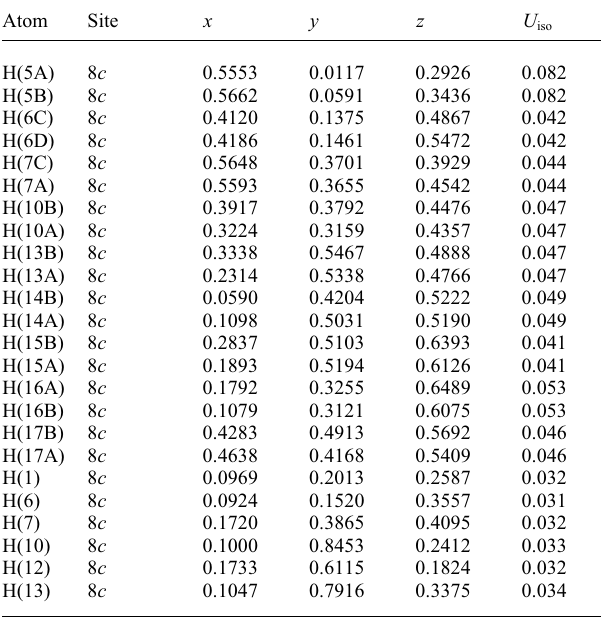
Table 2. Atomic coordinates and displacement parameters (in Å 2 )